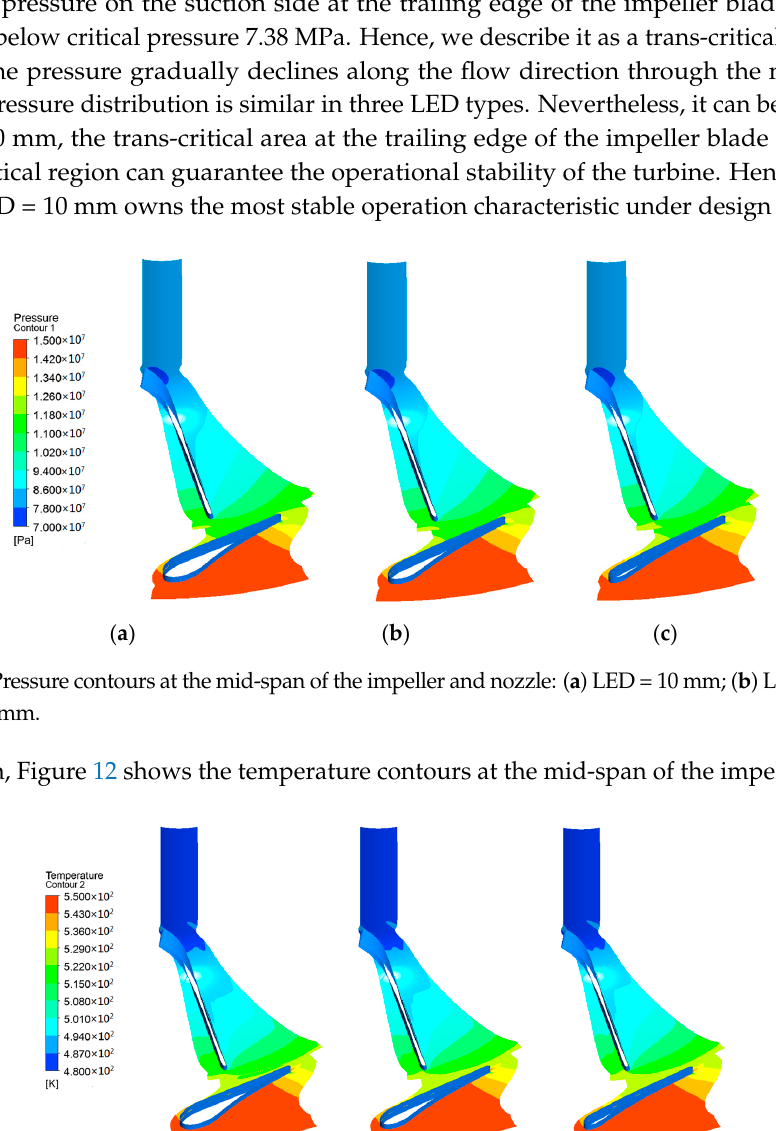
Figure 10. Mach number contours at the mid-span of impeller and nozzle: ( a ) LED = 10 mm; ( b ) LED = 7 mm; ( c ) LED = 4 mm.